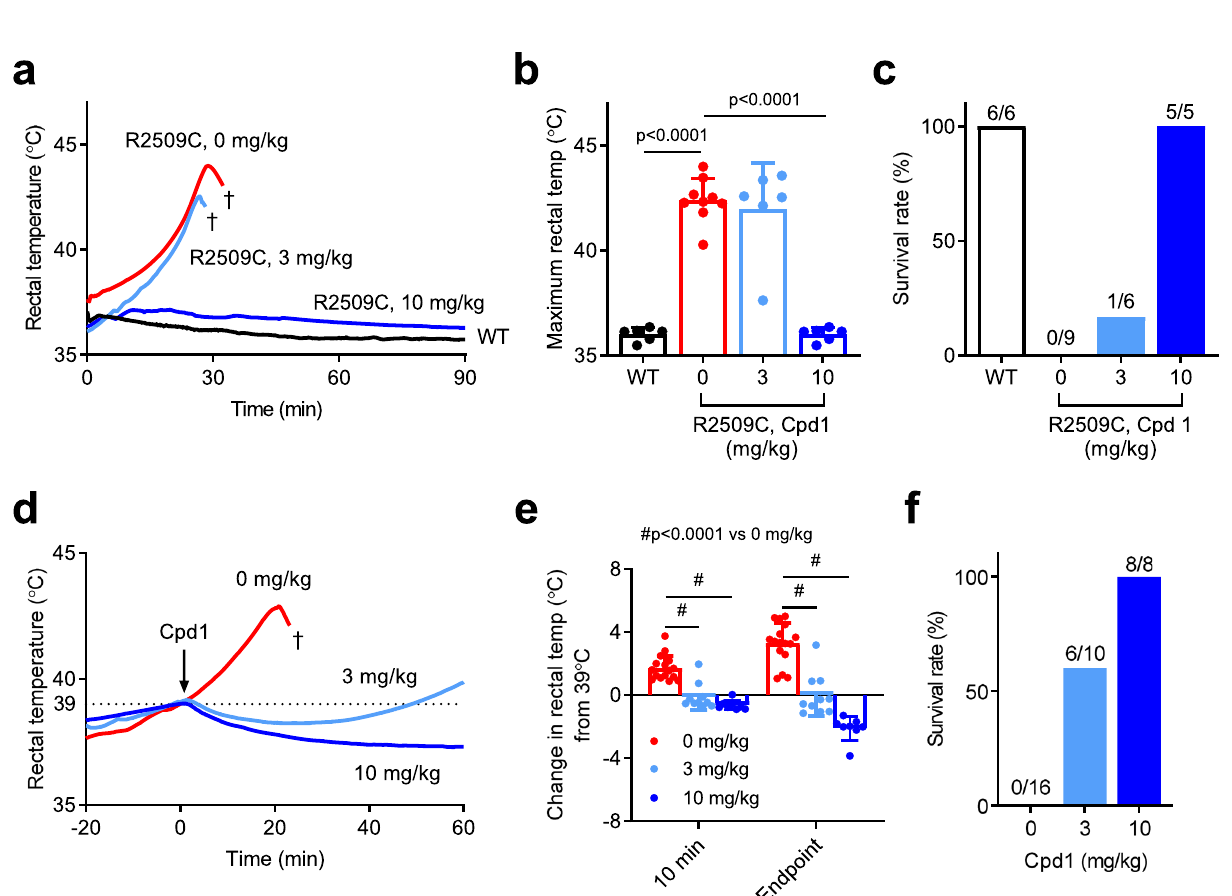
Fig. 4 In vivo iso fl urane challenge in WT and R2509C mice. a – c Preventive effects of Cpd1. a Time course of rectal temperature in mice after anesthesia by iso fl urane. Cpd1 (0, 3, 10mg/kg) was administered i.p. to R2509C mice 10min before anesthesia. † , death by fulminant MH crisis. b Maximum rectal temperature. Data are shown as means±SD (WT: n = 6; R2509C, 0mg/kg: n = 9; R2509C, 3mg/kg: n = 6; R2509C, 10mg/kg: n = 6) and were analyzed by one-way ANOVA with Tukey ’ s test. c Survival rate of mice after 90min of anesthesia. Administration of Cpd1 at 10mg/kg but not 3mg/kg prevented R2509C mice from fulminant MH crisis. d – f Rescue effects of Cpd1 on fulminant MH crisis in R2509C mice. d Time course of rectal temperature in mice after administration of Cpd1 during anesthesia. Mice were anesthetized by iso fl urane and Cpd1 (0, 3, 10mg/kg) was administered i.p. when their body temperature reached 39°C (arrow). † , death by fulminant MH crisis. e Change in rectal temperature of R2509C mice from 39°C at 10min after the administration of Cpd1 or saline control and the endpoint (60min after administration or just before death). Data are shown as means±SD (0mg/kg: n = 16; 3mg/kg: n = 10; 10mg/kg: n = 8) and were analyzed by one-way ANOVA with Tukey ’ s test. f Survival rate of R2509C mice 60min after administration of Cpd1 or saline control. Source data are provided as a Source Data fi n = 3). Muscle weakness was transiently observed after the repeated administrations in both male and female, but it returned to normal by 60 min (Fig. 6h).